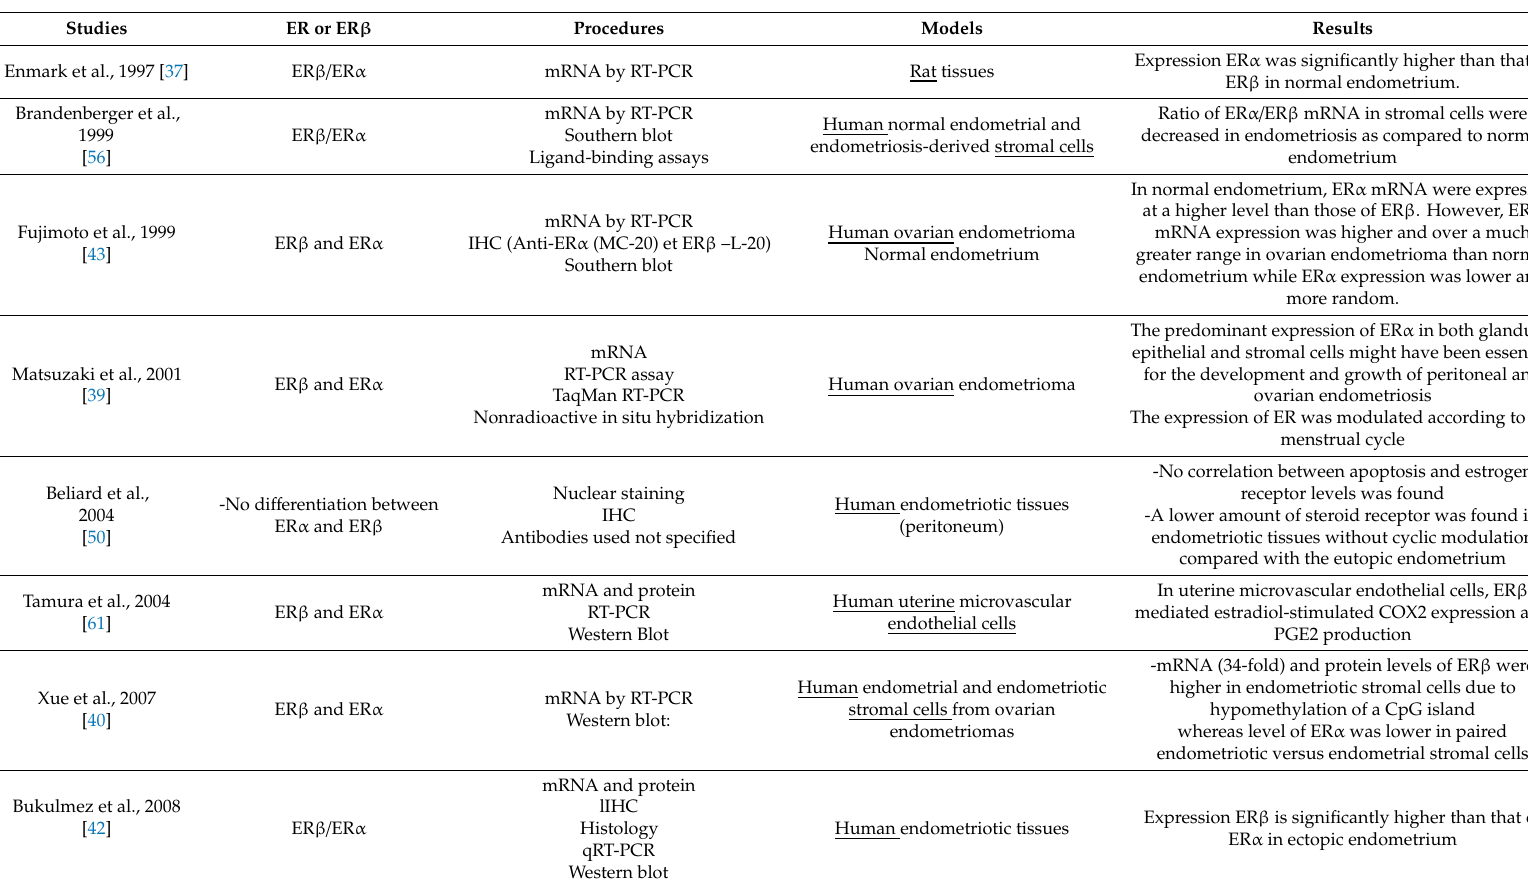
Table 1. Summary of the di ff erent studies on ER α and ER β expression in endometriosis. IHC = Immunohistochemistry; IP = Immunoprecipitation. The “underline” is to emphasize the species: Human, mouse or rat and to also emphasize some cell types such as stromal or endothelial